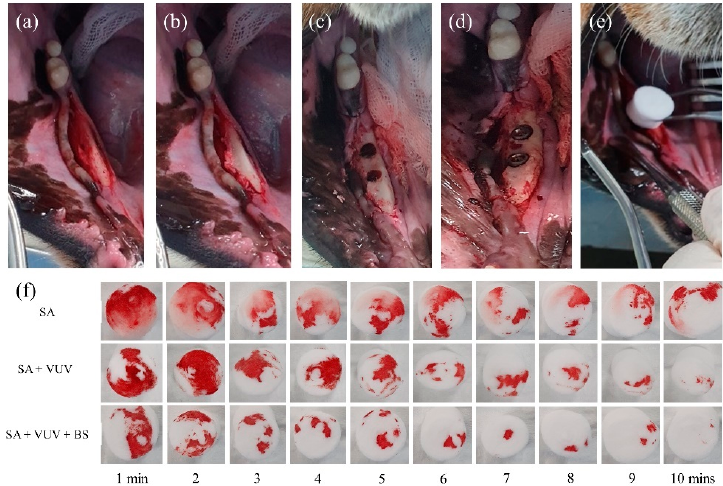
Figure 3. In vivo test of blood clotting: ( a ) incision and flap reflection; ( b ) alveolar ridge flattening; ( c ) preparation of implant holes; ( d ) implant fixture placement; ( e ) cotton pellet application for bleeding absorption; ( f ) pattern of cotton pellets according to time. SA, a conventional SA surface; SA + VUV, an SA surface with vacuum-UV treatment; SA + VUV + BS, an SA surface coated with a pH-buffering agent after vacuum-UV treatment.